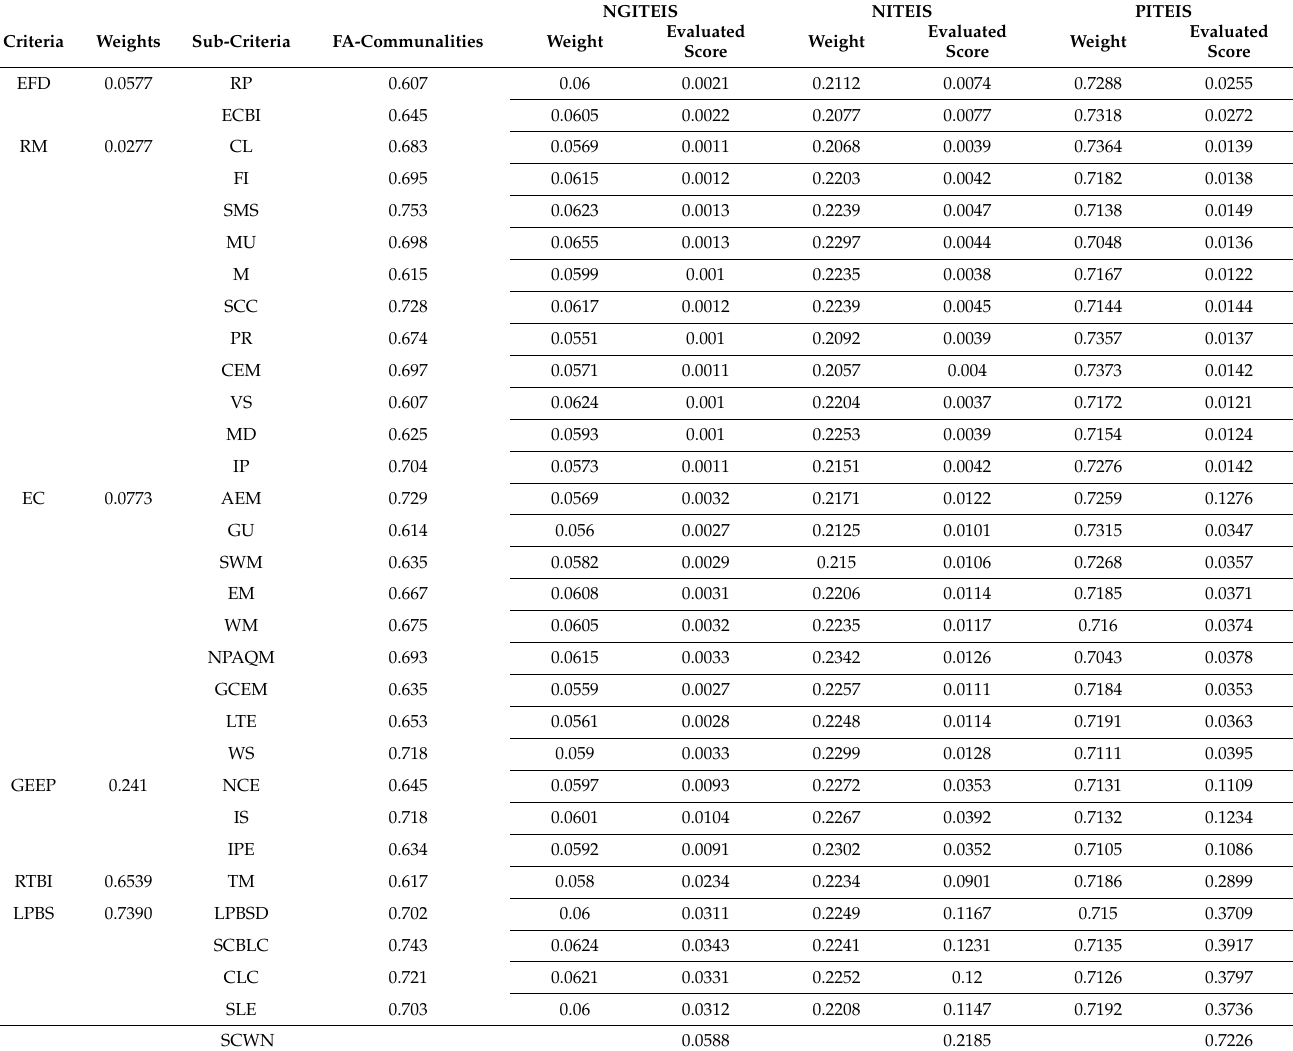
Table 5. The evaluated measurements of the ANP hierarchical